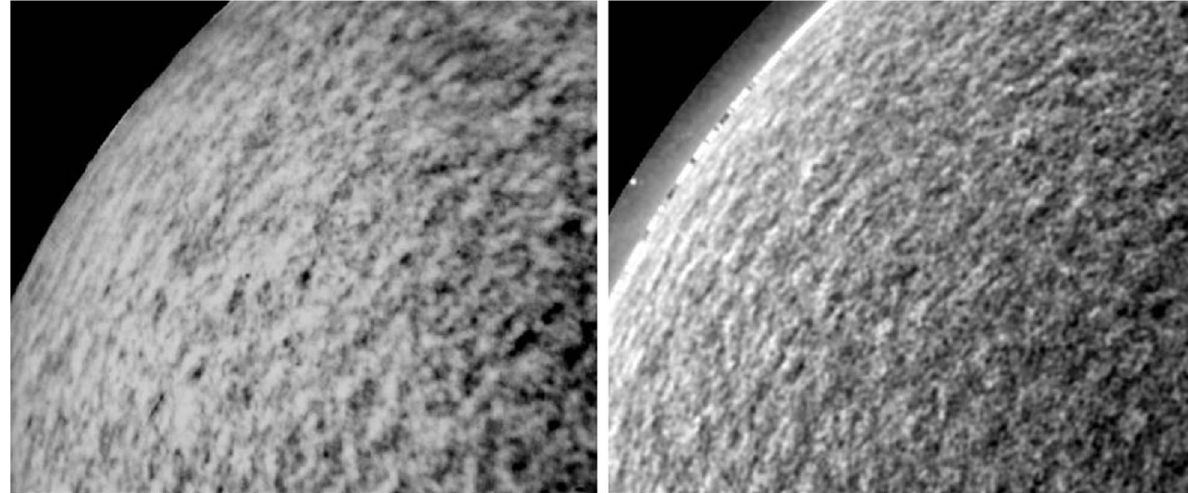
Fig. 11. Comparison between the K dopplergrams of SAMM (left) and SDO (right) in the same fi eld of the Active region 12,749 (Courtesy of NASA/SDO and the AIA, EVE, and HMI science teams). Full frame: 10 0 (cid:3) 8.3 0 .